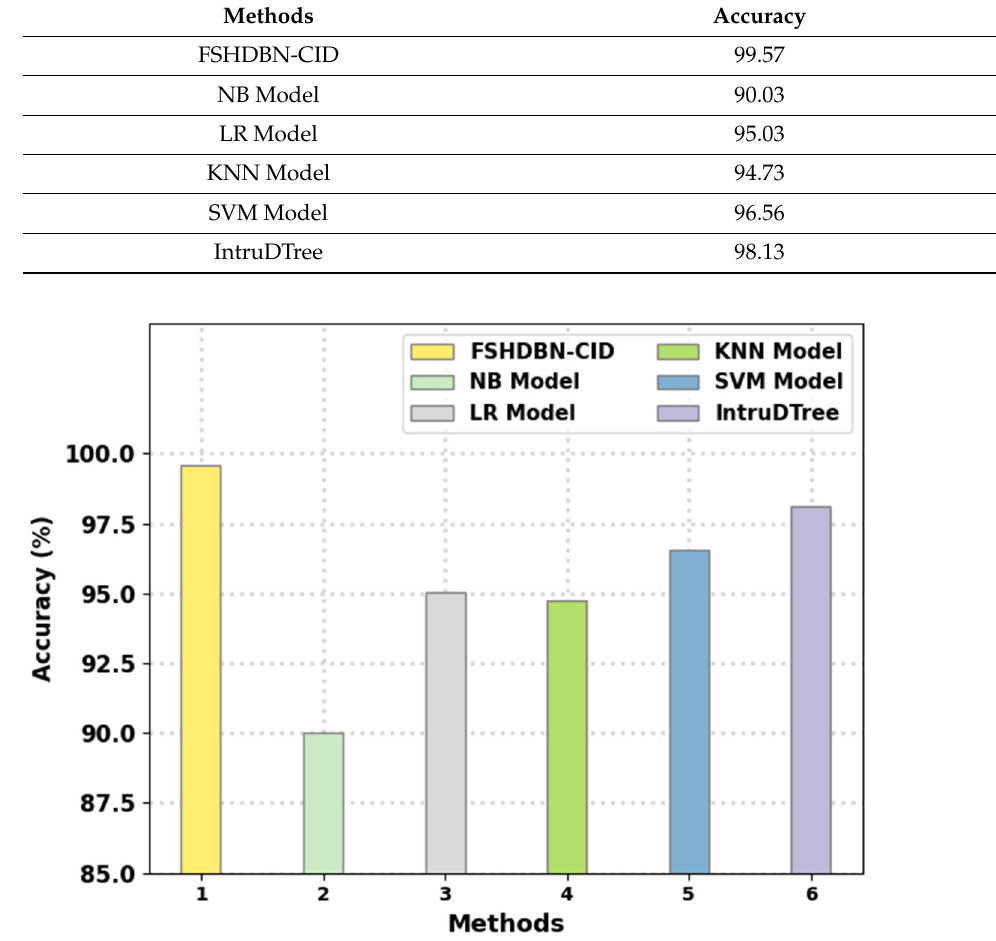
Figure 12. Accu y analysis of FSHDBN-CID approach with existing Figure 12. 𝐴𝑐𝑐𝑢 (cid:3052) analysis of FSHDBN-CID approach with existing methodologies.